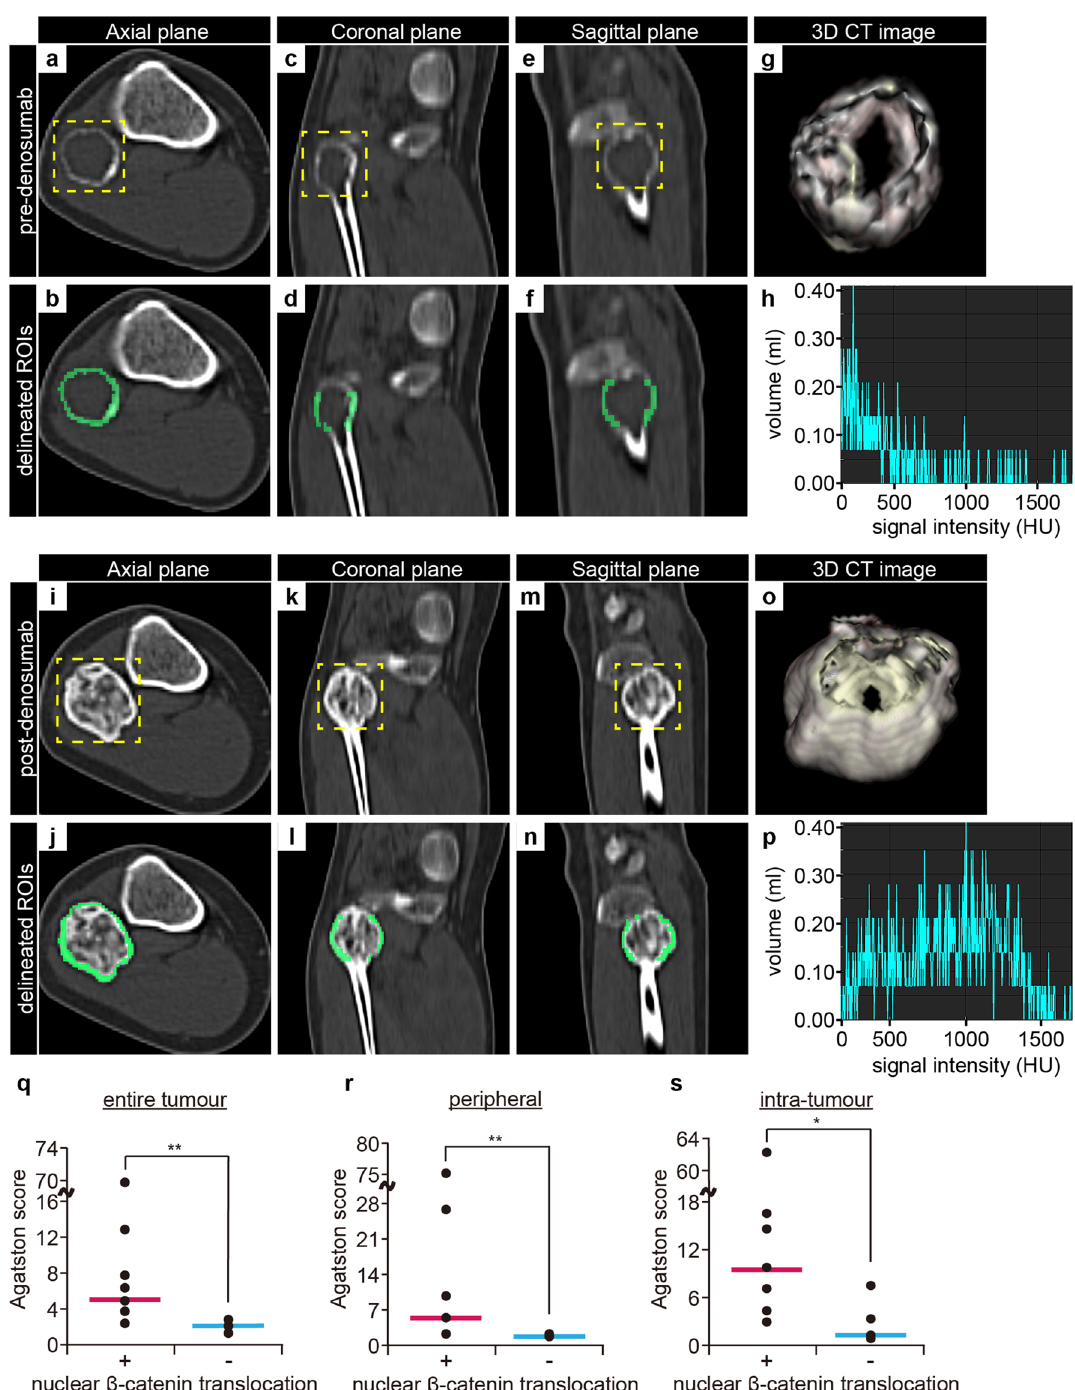
Figure 7. Nuclear β-catenin positivity of GCTB-SCs is significantly associated with bone formation after denosumab treatment. To elucidate the relationship between β-catenin stainability and tumoral ossification, we performed quantitative evaluations using SYNAPSE VINCENT. ( a – g ) Representative images of three-dimensional analysis before denosumab treatment (case #2). ROI in the axial ( a , b ), coronal ( c , d ), and sagittal ( e , f ) CT images were delineated, and the 3D tumor model was automatically depicted ( g ). ( h ) Histogram image of the ROI before denosumab treatment. Tissue volumes with more than 130 HU were identified as significant calcifications, and Agatston scoring was performed as previously described 27, 28 . ( i – n ) Representative three-dimensional image after the treatment. ROI in the axial ( i , j ), coronal ( k , l ), and sagittal ( m , n ) CT images were used for 3D model analysis ( o ). Bright yellow lines represent the peripheral rim of the ROI. ( p ) Histogram image of the ROI after denosumab treatment. In the ossified case, the histogram image was leptokurtic, and the degree of skew was significant. ( q – s ) The relationship between nuclear β-catenin stainability and intra-tumoral ossification was evaluated using Agatston score (n = 13). The stainability was significantly associated with the score in the entire ( q ), peripheral ( r ), and intra-tumoral areas ( s ) ( ** P = 0.003 for entire and peripheral tumor, and * P = 0.02 for intra-tumor of GCTB). Each post-treatment Agatston score was normalized against the corresponding pre-denosumab